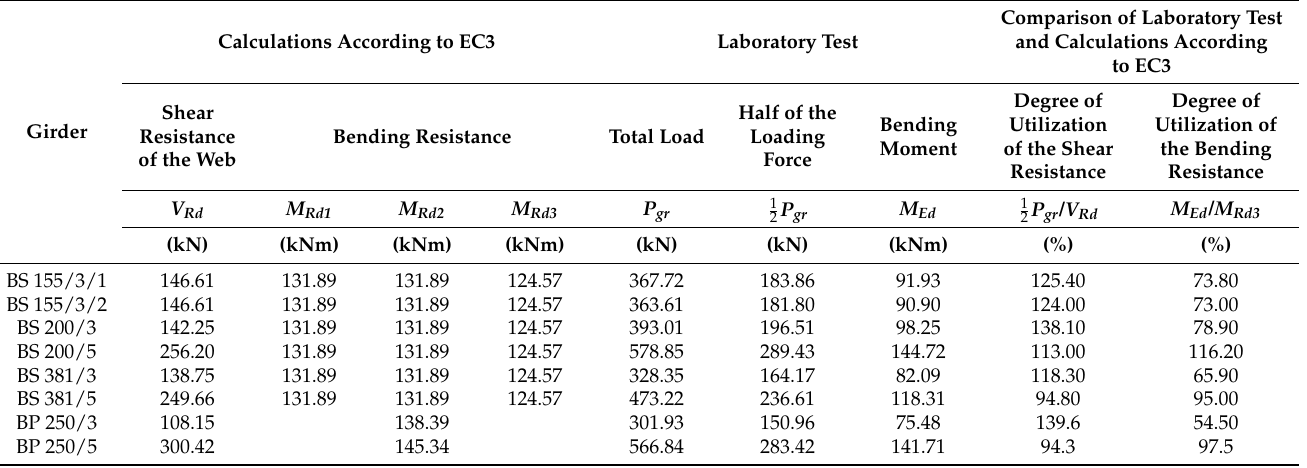
Table 3. Determined standard load capacities according to EC3 [30,34] and limit loads obtained during own tests.